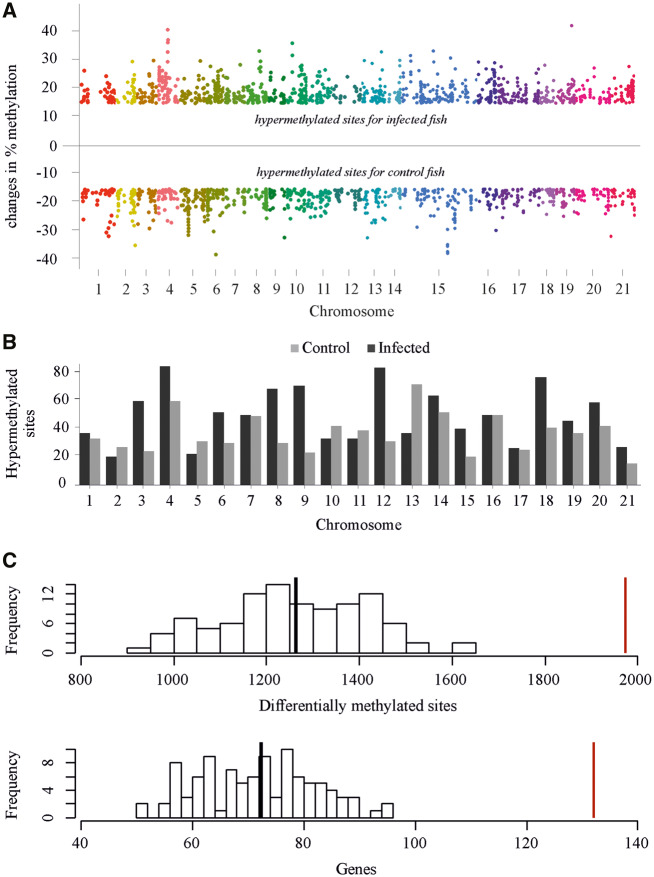
DMSs. (A) Manhattan plot of the differentially methylated CpG sites (DMS) across chromosomes between infected and uninfected fish. The y axis represents the methylation percentage of the difference for a position. Only DMS higher than 15% change in methylation are presented. (B) Barplot of the number of hypermethylated sites per chromosome between infected and control fish. (C) Number of DMS and their associated genes of the randomized sets. Black vertical line indicates the average number of DMS and genes of the randomized sets, whereas the red line refers to the number of DMS and genes of the original data set.